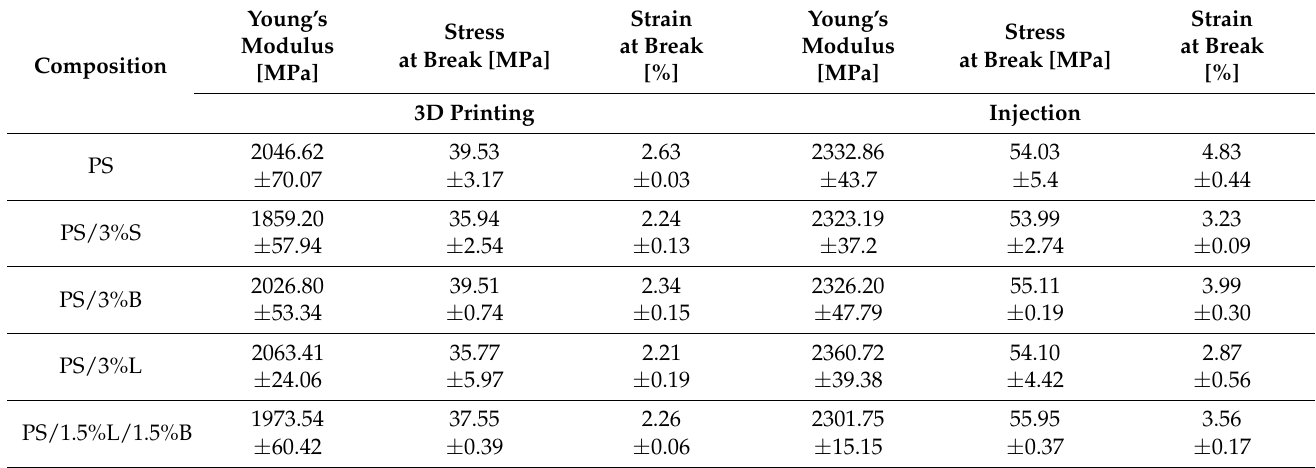
Table 4. Results of mechanical tests of PS and composites based on